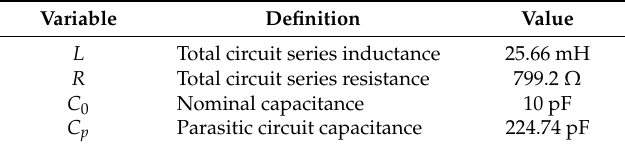
Table 2. The electrical properties of the resonator.